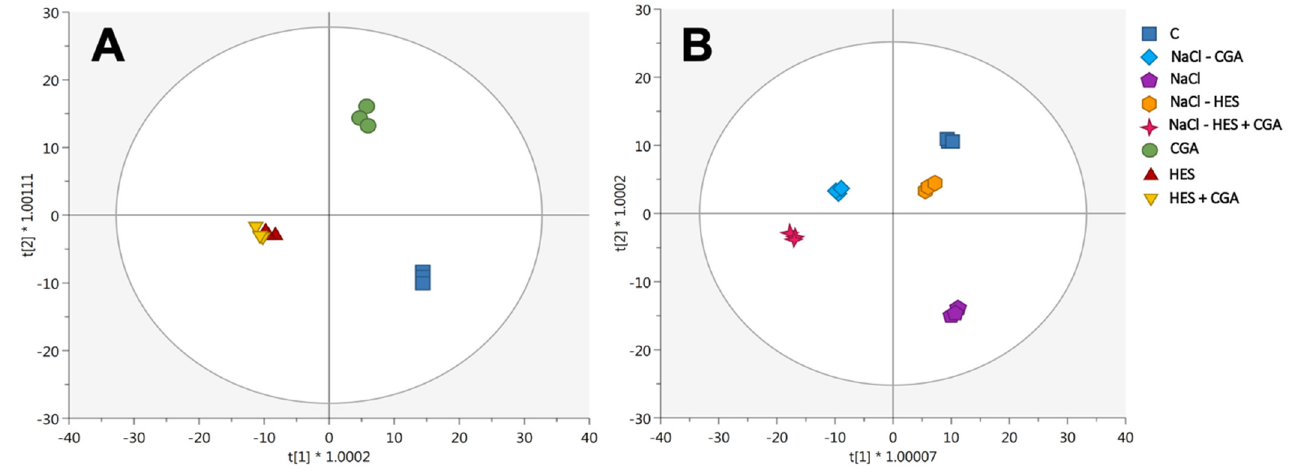
Figure 2. Supervised orthogonal projections to latent structures discriminant analysis (OPLS-DA) score plot built according to the phenolics of lettuces treated with: control non-treated (C), 100 µM hesperidin (HES), 50 µM chlorogenic acid (CGA), and 100 µM hesperidin + 50 µM chlorogenic acid (HES + CGA). The treatments were performed both under non-salt ( A ) and salt-stressed ( B ) conditions.